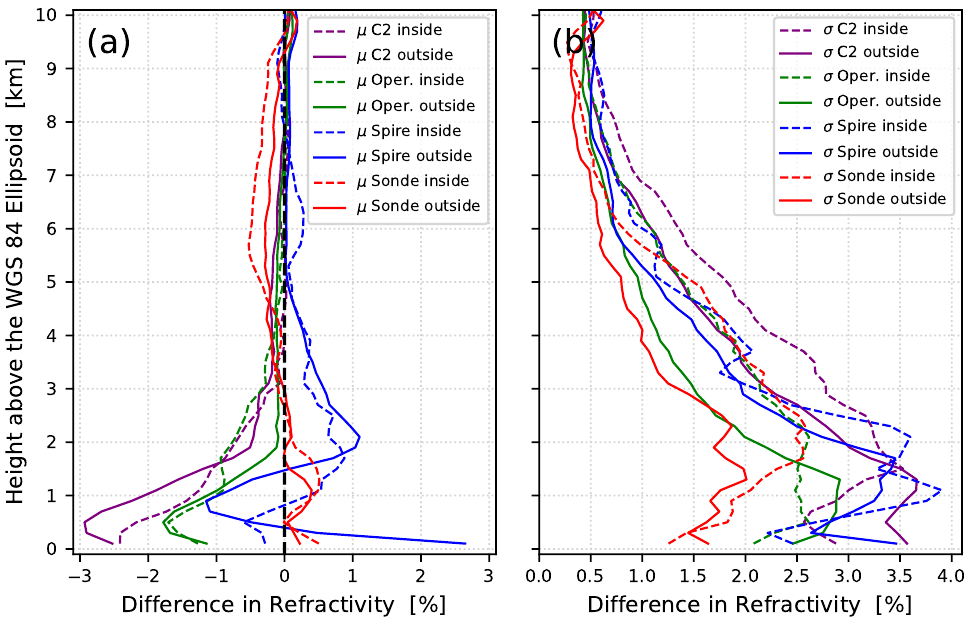
Figure 17. Comparison of ( a ) the mean difference in refractivity (%) and ( b ) the standard deviation (%) of the differences between each of the observed datasets and the ERA5 reanalysis product for both within (dashed lines) and outside (solid lines) the atmospheric river. The operational (green lines), COSMIC-2 (purple lines), Spire (blue lines), and dropsonde (red lines) datasets are shown. The thick dashed black line highlights the line of zero